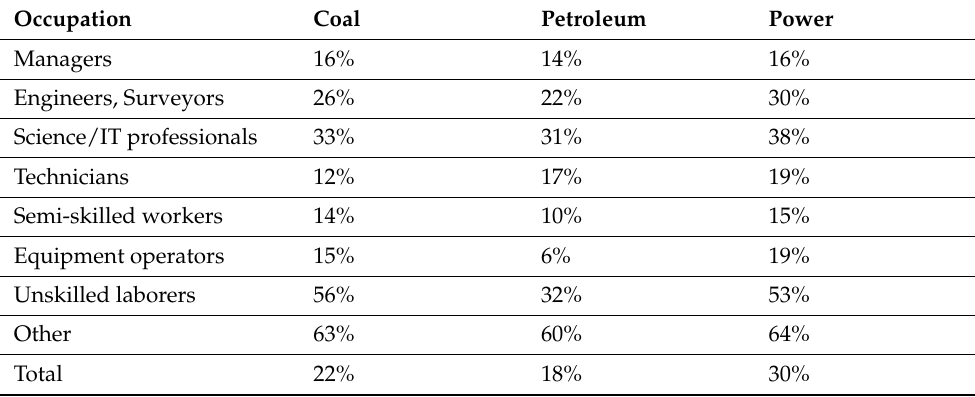
Table 2. Share of women in the total workforce by occupation, average, 2010–2020. Occupation Coal Petroleum Power Managers